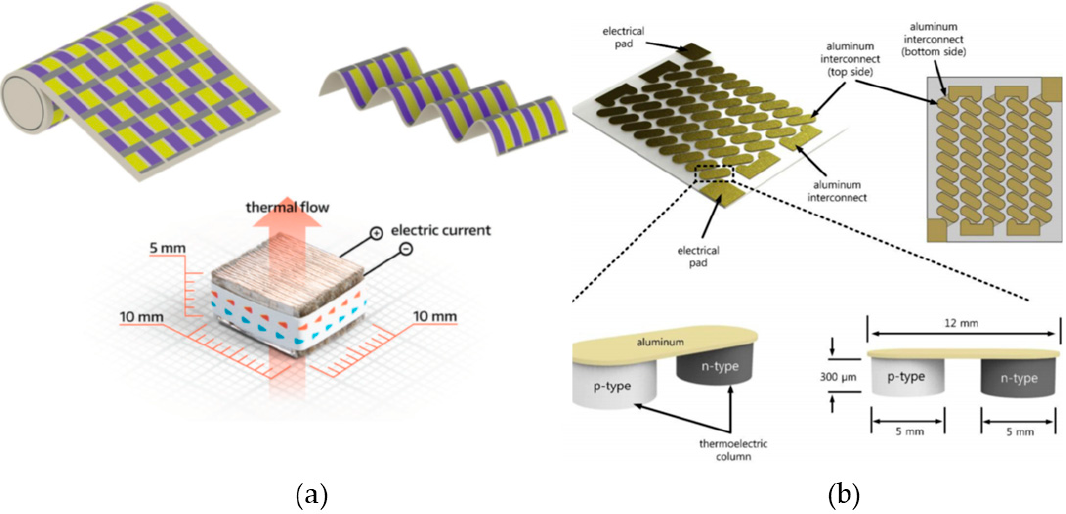
Figure4. ( a )ProcessingofaflexibleorigamiTEG;( b )flexiblethermoelectricgeneratorwithpolydimethyl Figure 4. ( a ) Processing of a flexible origami TEG; ( b ) flexible thermoelectric generator with siloxane polydimethyl siloxane [43].